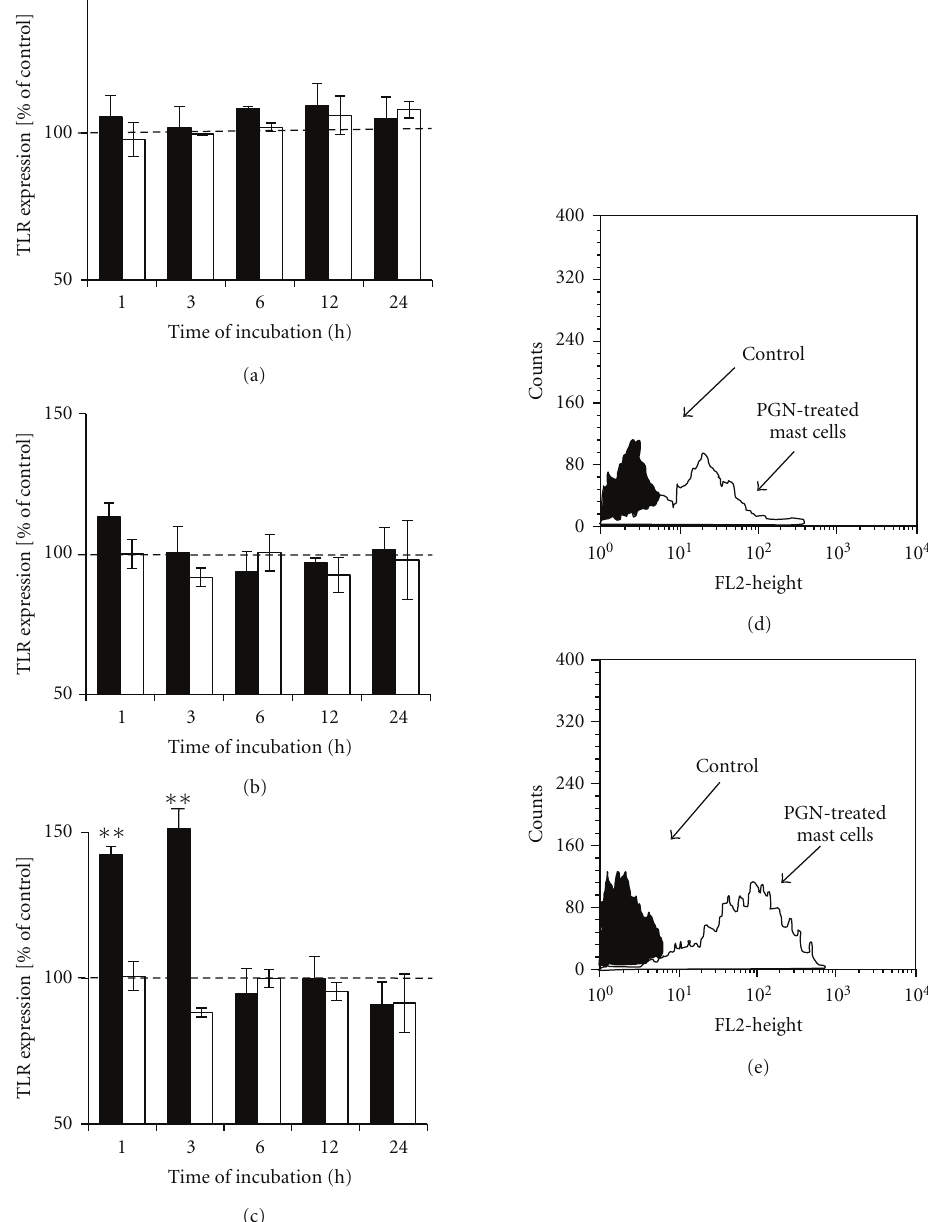
Figure 3: The e ff ect of (a) LPS, (b) LAM, and (c) PGN on TLR2 expression on rat mast cells. Mast cells were incubated with bacterial components or cDMEM (control TLR2 expression on unstimulated cells referred to as 100%) for 1, 3,6,12, or 24 hours. LPS concentrations − 1ng/mL (dark bars) and 10 2 ng/mL (bright bars) LAM and PGN concentrations − 1 μ g/mL (dark bars) and 10 2 μ g/mL (bright bars). Results are presented as a percentage of control TLR2 expression. Each point represents the mean ± SEM of 6 independent experiments. ∗∗ P < . 01. (d) Representative flow cytometry histogram showing TLR2 expression on rat mast cells treated with 1 μ g/mL PGN for 1h. (e) Representative flow cytometry histogram showing TLR2 expression on rat mast cells treated with 1 μ g/mL PGN for 3h. Filled histograms: untreated mast cells (control) and open histograms: PGN-treated mast